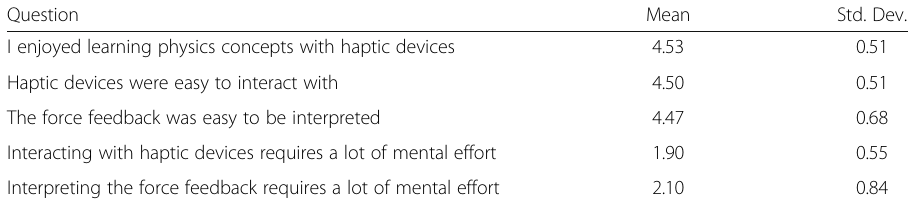
Table 7 Descriptive statistics of students ’ responses to the motivation, usability and effort survey